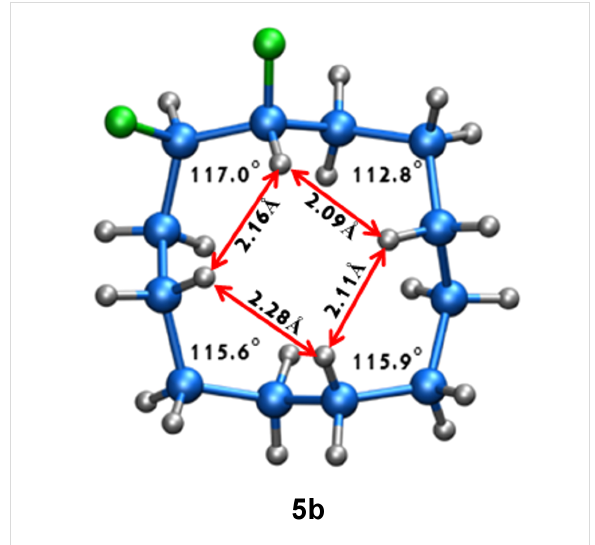
Figure 4: X-ray crystal structure of threo -1,2-difluorocyclododecane ( 5b ) showing corner angles and representative transannular contact